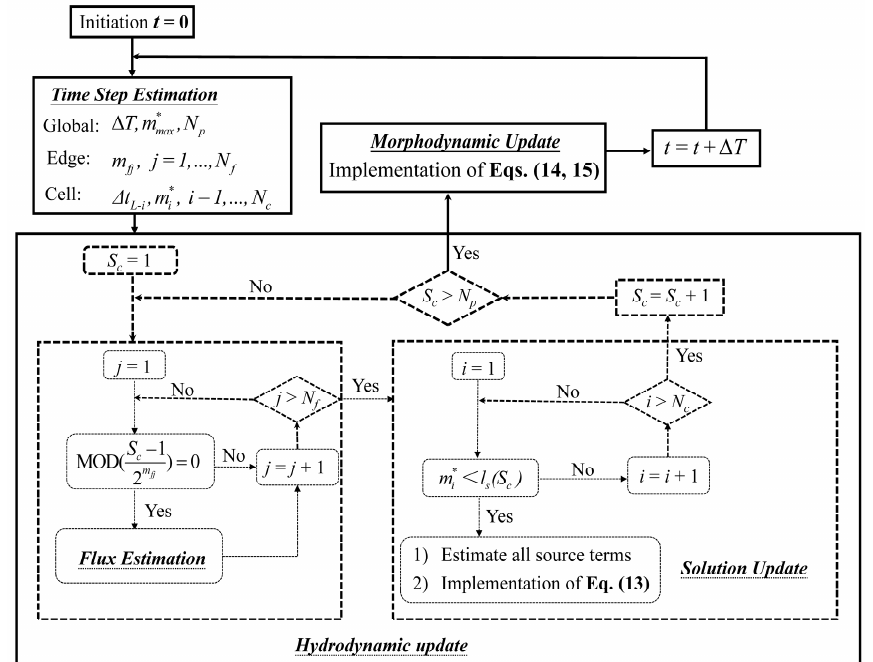
Figure 2. Sketch of the numerical structure (revised from Hu and Li [36]).